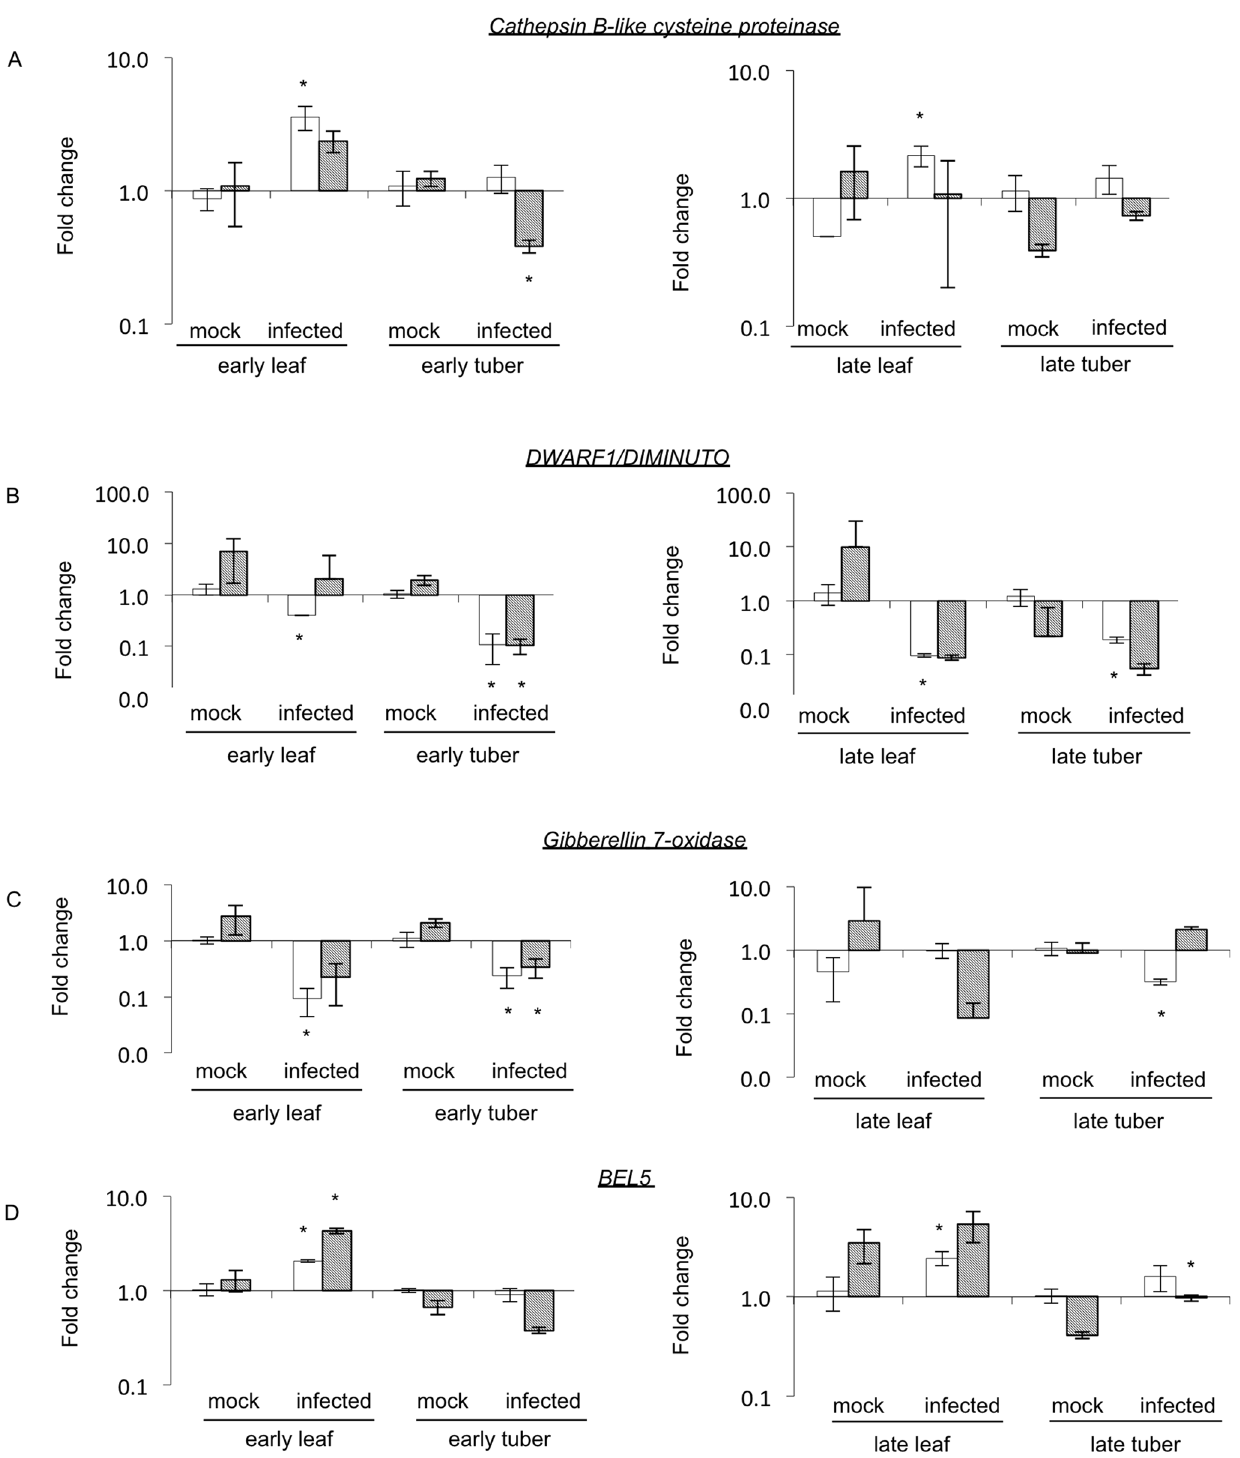
Fig 4. Quantitative RT-PCR analysis of candidate genes. Mock infected plants were used to normalize fold change of early and late samples in leaf and tuber tissues as indicated. White bars represent the RT-qPCR analysis; grey bars show the microarray data. Error bars represent standard error (SE). L23 and PP2A genes were used as internal normalization controls. Asterisk indicates that the means of fold change of the mock and infected samples are significantly different (Student ’ s t-test).